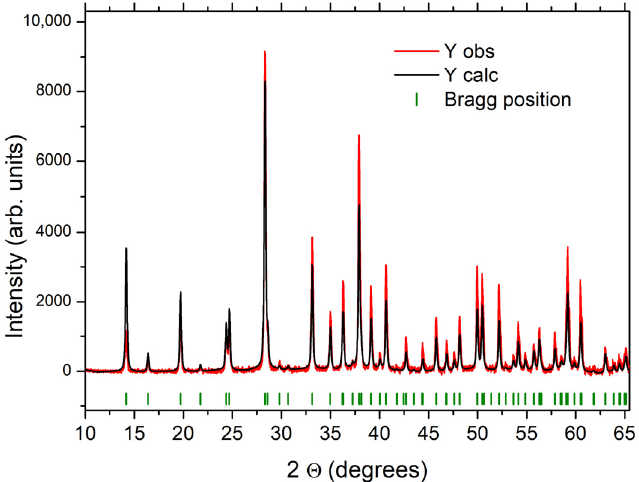
Figure 5. Rietveld refinement of the X-ray Diffractogram for the S LowTP sample in the P6 3 mc space group. The experimental XRD pattern is a red line, the calculated pattern a black line.